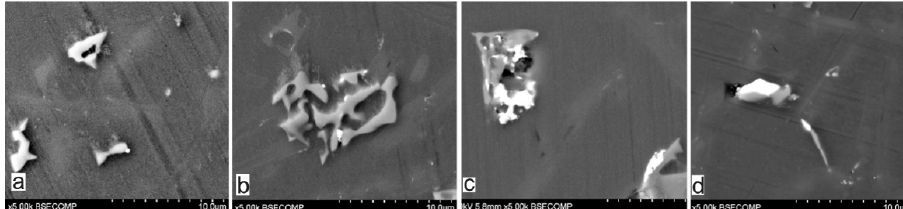
Figure 10. Microstructure of AlSi10 alloy with Sn addition (BSE—mag. 5000×): ( a ) AlSi10; ( b ) AlSi10Sn0.2; ( c ) AlSi10Sn0.4; ( d ) AlSi10Sn0.7.